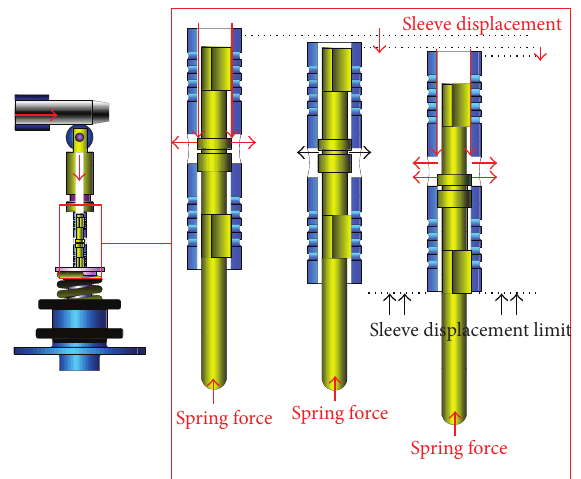
Figure 13: Schematic of constant power regulator in the case of flow rate cut-off.